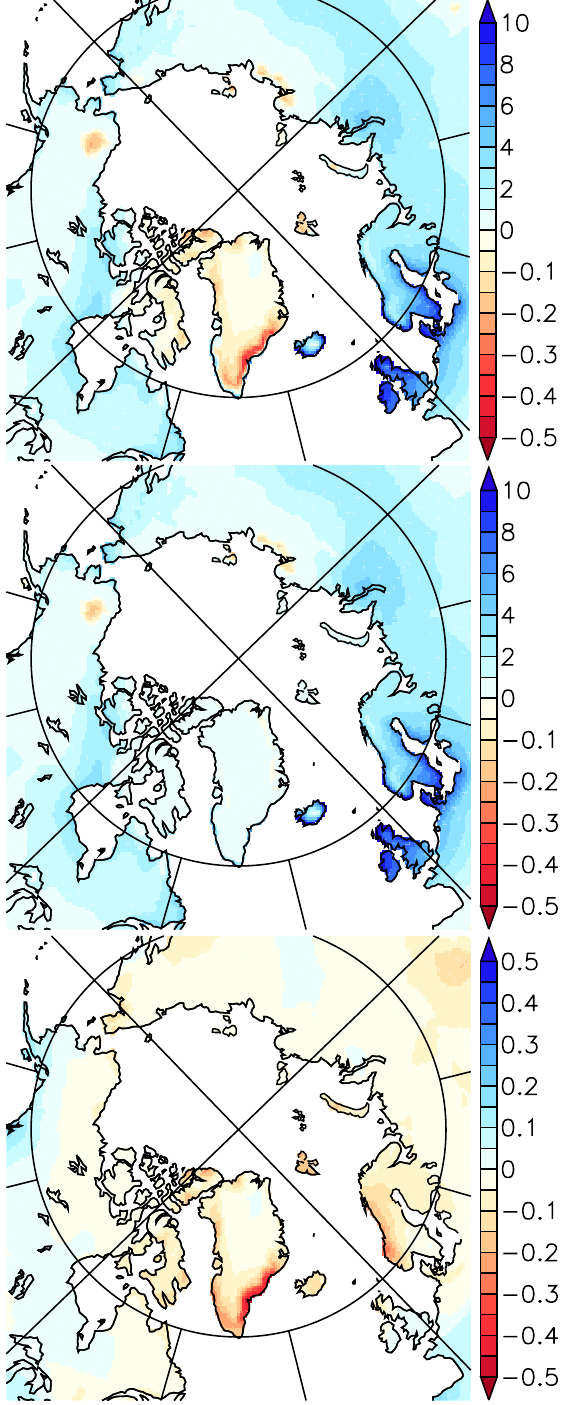
Fig. 8. Mass balance difference (myr − 1 ) between atmosphere only experiment with 3 ◦ C lower sea surface temperatures and the con- trol run (upper), decomposed into melt (middle) and precipitation differences (lower). Lower sea surface temperatures strongly facili- tate ice growth in most regions by decreasing melting. The negative effect of weaker moisture supply is limited and dominates over melt only in areas that are already glaciated in the unperturbed 115ka ex- periment. Note the different scale in the lower